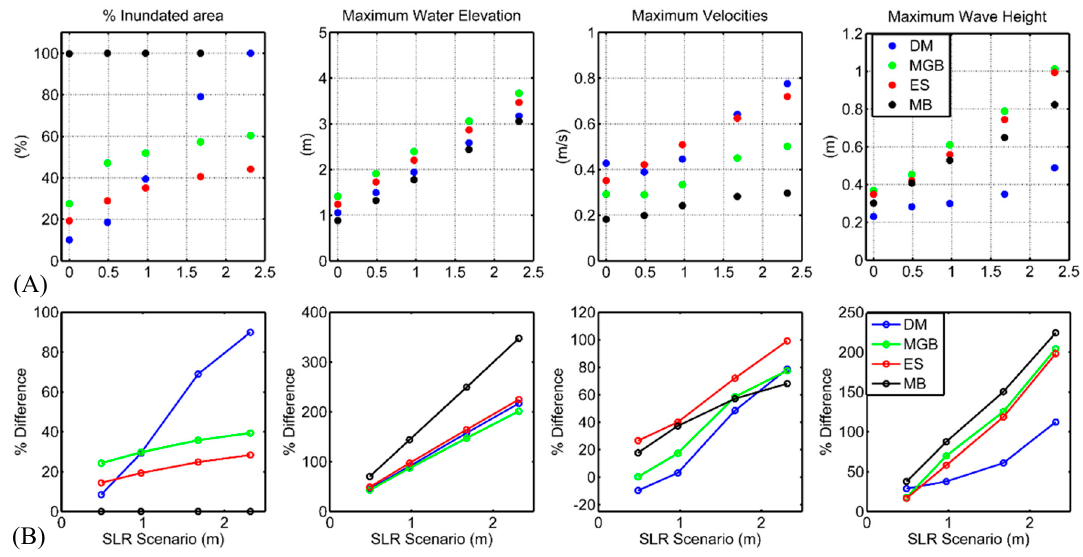
Figure 9. Overall impacts of SLR and marsh migration on Percentage of inundated area, maximum water levels, maximum currents and maximum wave heights at each preserve area. The top panel ( A ) shows the average of the simulated Percentage of inundated area, maximum water levels, maximum currents and maximum wave heights for the selected storms in both current and future scenarios while in the bottom panel ( B ) percentage increase of each of the parameters from the current condition are shown for the selected sites.